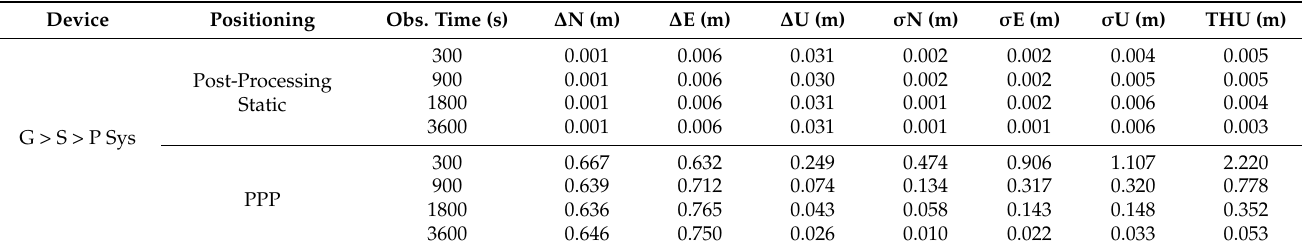
Table 10. Performance in static positioning post-processed in static mode and PPP mode of the G > S > P Sys.